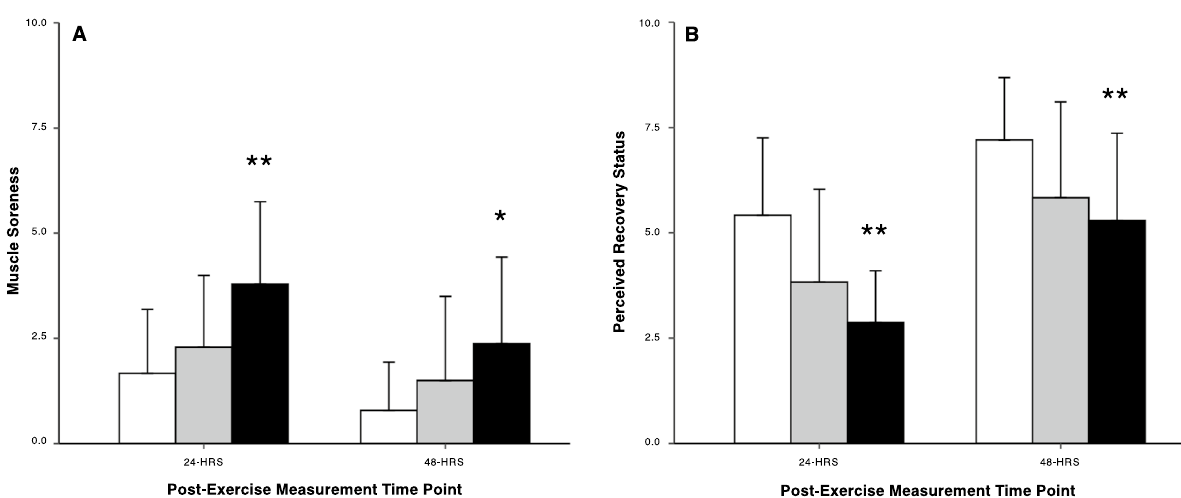
Fig. 8 Ratings of muscle soreness ( A ) and perceived recovery status ( B ) at 24 and 48 h post-exercise. Data shown are presented as mean *Denotes a statistically significant difference from 3-RIR. **Denotes a statistically significant difference from 1-RIR and